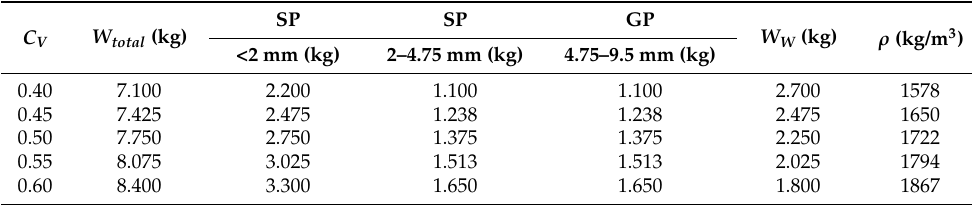
Table 2. Weights of mixed samples for laboratory tests.